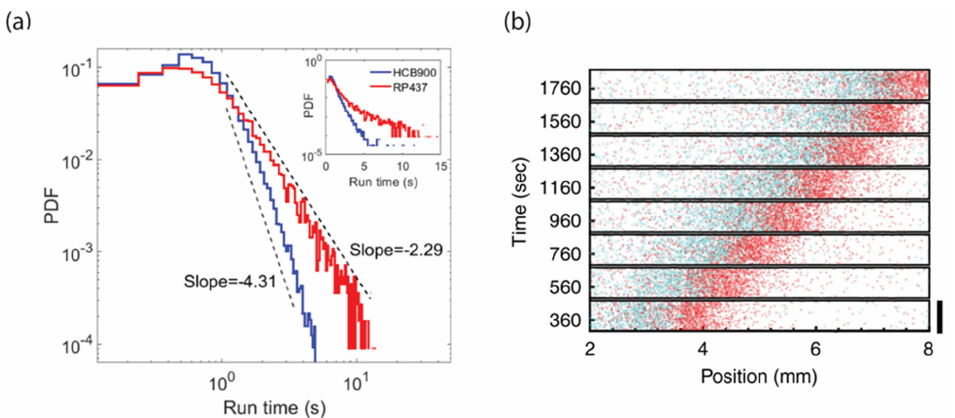
Figure 2. Phenotypic diversity and signaling fluctuations affect ecological performance. ( a ) The distribution of run lengths in wild-type cells (red) has a fatter tail than in cells with the same mean tumble bias but no fluctuations in CheY phosphorylation (blue). This distribution of run lengths allows cells to efficiently explore the environment by Levy walk instead of a pure random walk. ( b ) The conflict between individuality and collective behavior is resolved by spatial sorting of phenotypes in traveling waves of bacteria. Cells with lower tumble bias (red) climb attractant gradients more quickly than cells with higher tumble bias (blue), and therefore are located near the front of the wave. Panels a and b are adapted with permission from Huo et al., 2021 [85]; Fu et al., 2018 [87].